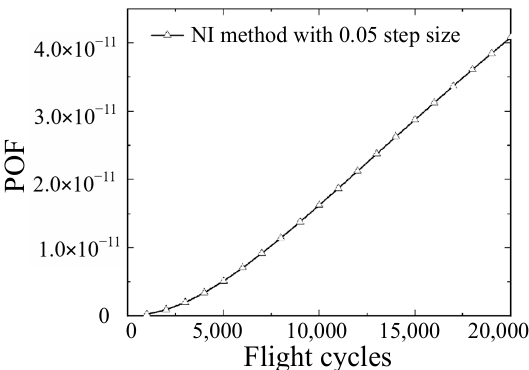
Figure 10 . Convergence results of the NI method with a 0.05 step size. (2) Cases with MCS for different sample sizes